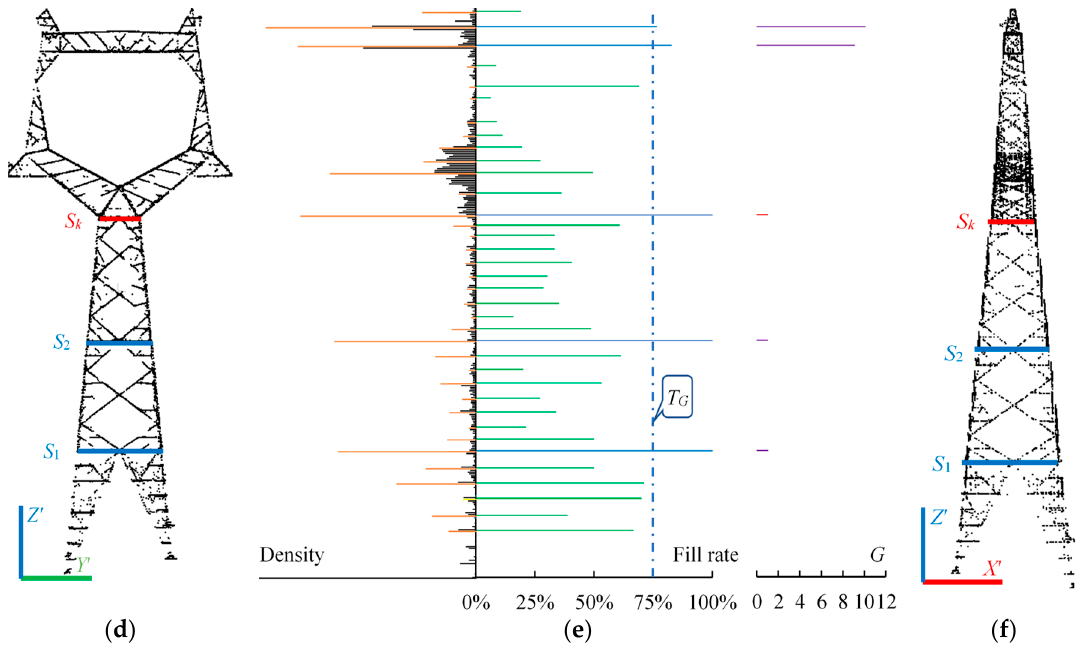
Figure 5. Pylon decomposition: ( a,d ) The projection view of pylon in the Y ′ Z ′ plane, and blue lines are the segmentation positions (SP) and the red line is the key segmentation position (KSP); ( b,e ) density, filling rate, and projection shape parameter histogram; ( c,f ) the projection view of pylon in the X ′ Z ′ plane, and blue lines are the segmentation position and red line is the key segmentation position.